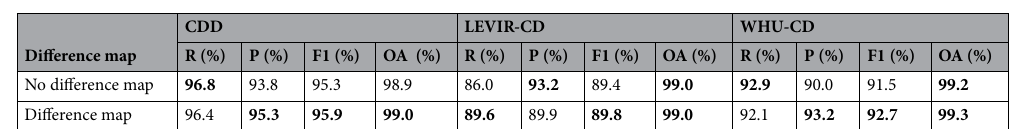
Table 7. Impact of difference map (the best performance is emphasized in bold).